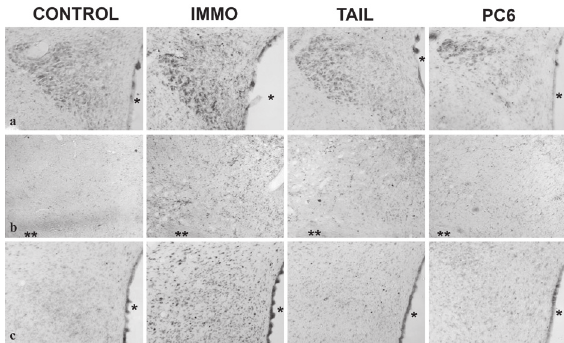
Figure 3 - Photomicrographs of coronal sections of rat brain regions with significant increases in Fos immunoreactive cells (dark spots) in rats submitted to immobilization stress (IMMO) as compared to control non-stressed rats (control) and the absence of activation in rats submitted to immobilization stress plus electroacunpucture in the tail or PC6. (a) paraventricular nucleus, (b) lateral hypothalamus, and (c) dorso medial hypothalamic nucleus. *indicates the third ventricle and **indicates the optic tract. Magnification,